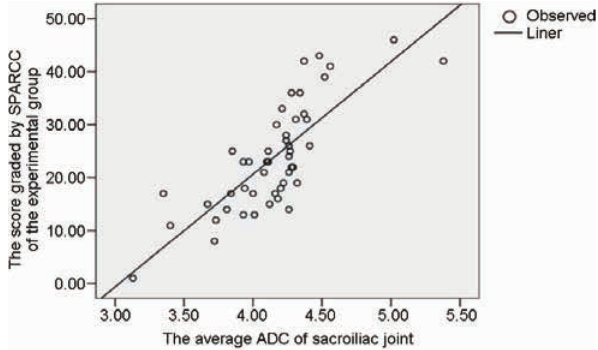
Figure 1: SPARCC scoring in experimental